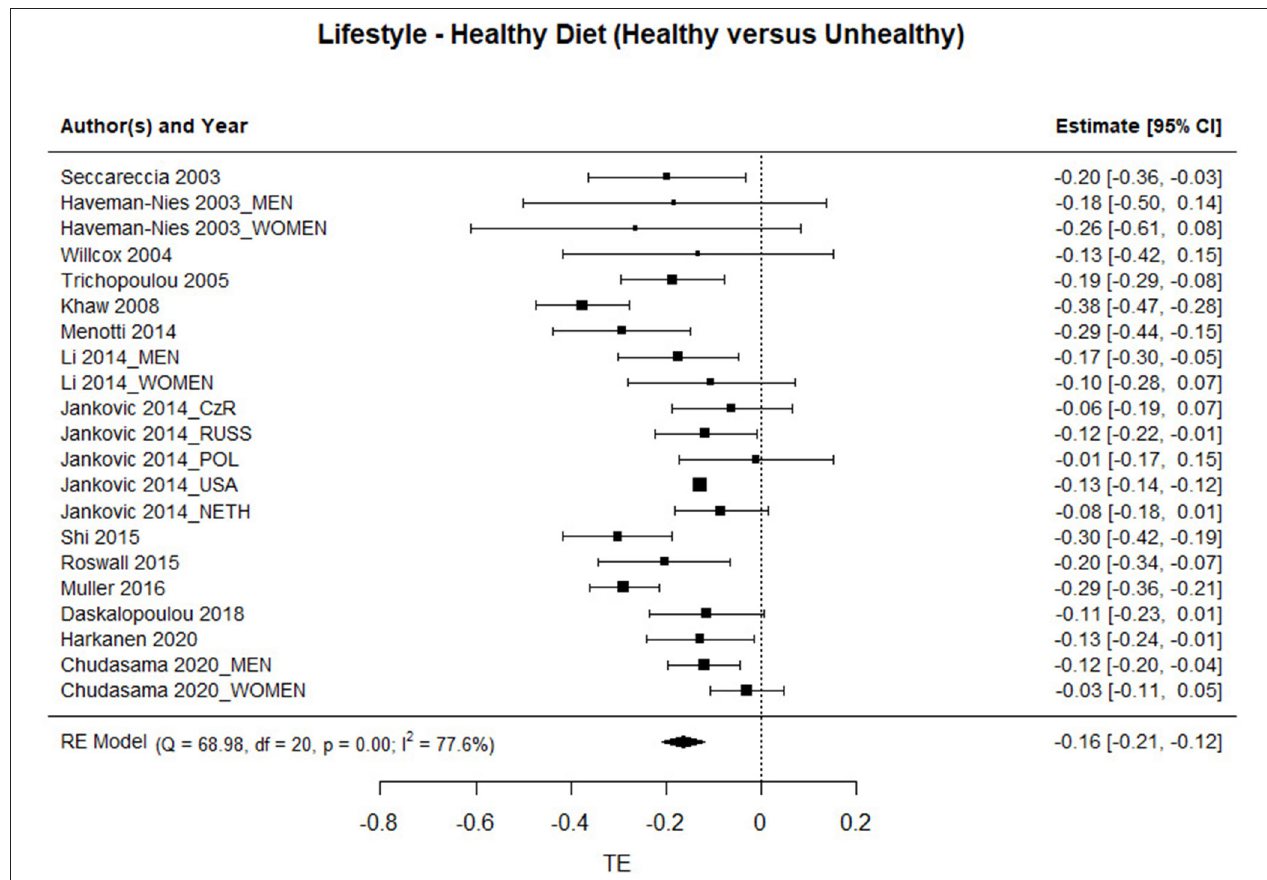
FIGURE 4 | Association between having a healthy diet and the risk of